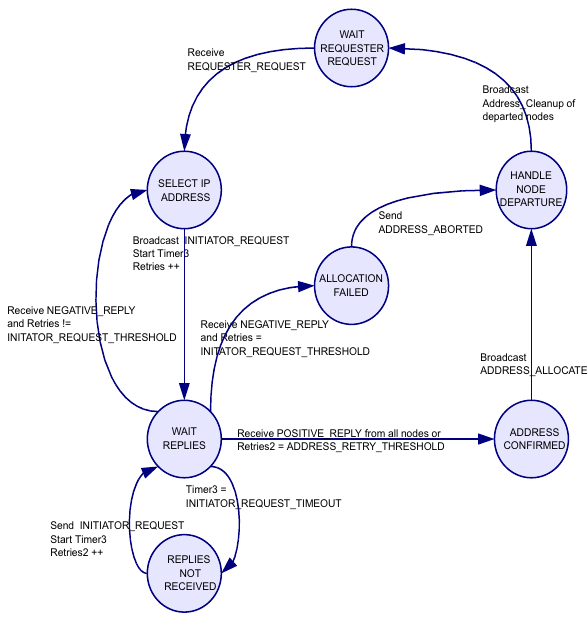
Figure 2. State diagram of an initiator node during the address allocation process of MANETconf